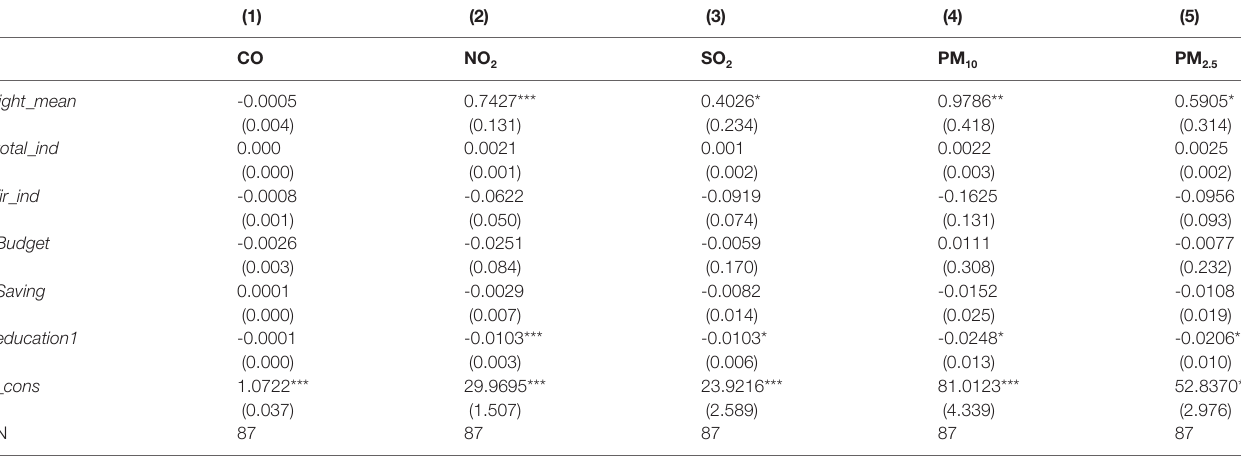
TABLE 8 | The impact of economic development on air pollutants with replacing control variables. (1)